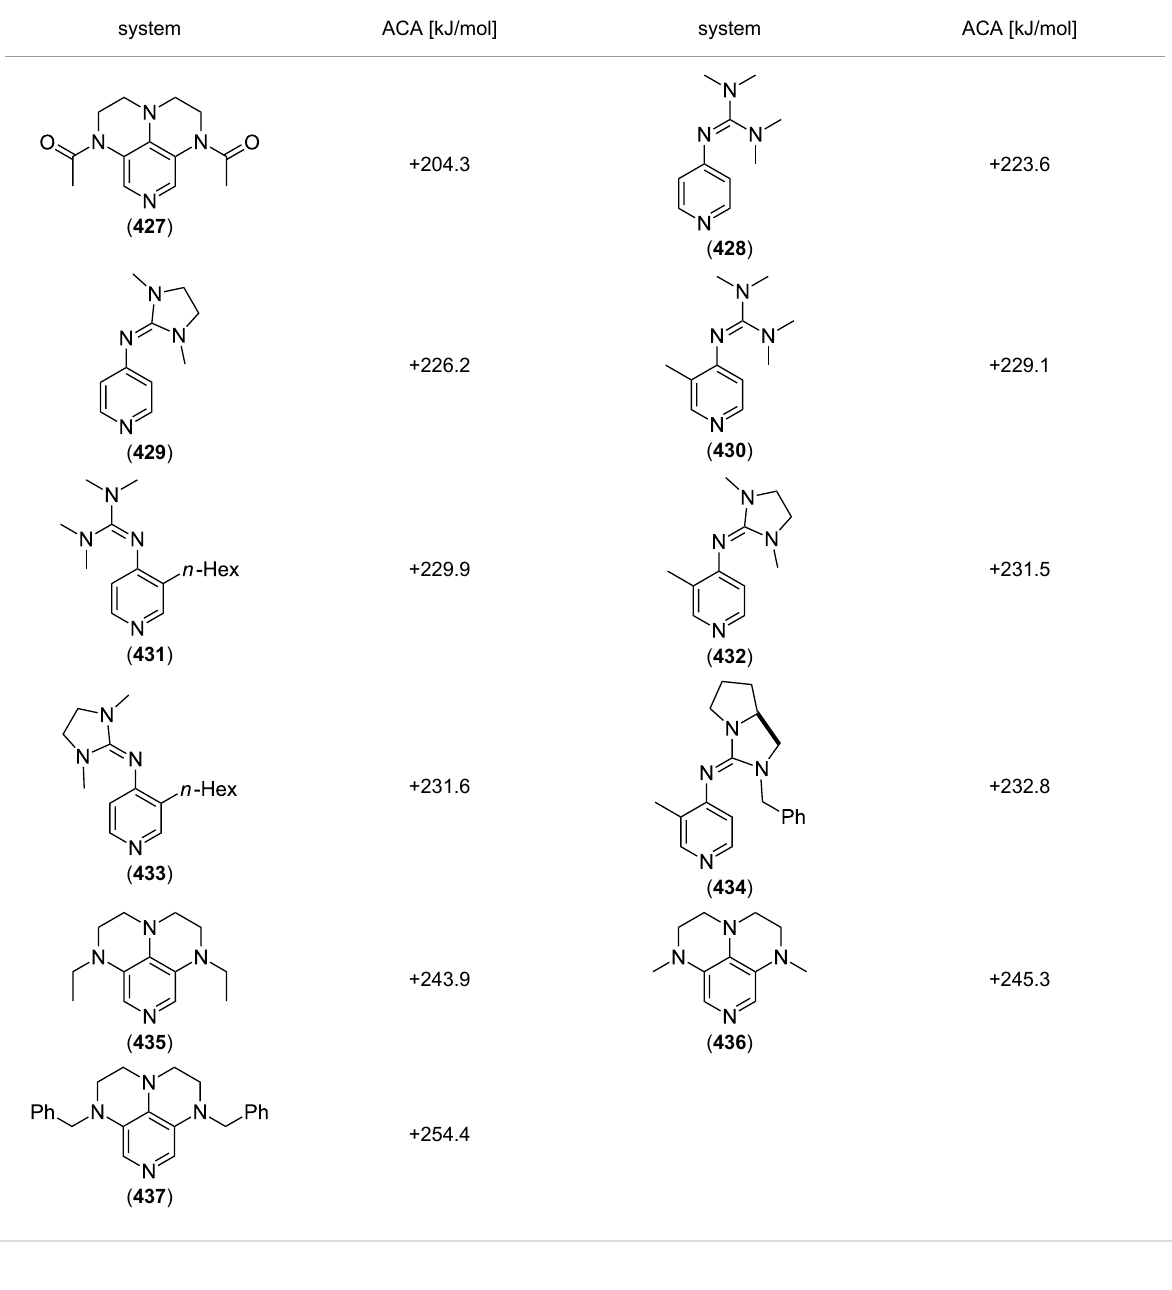
Table 16: ACA values of 3,4,5-triaminopyridines and guanidines, ordered by increasing ACA values.